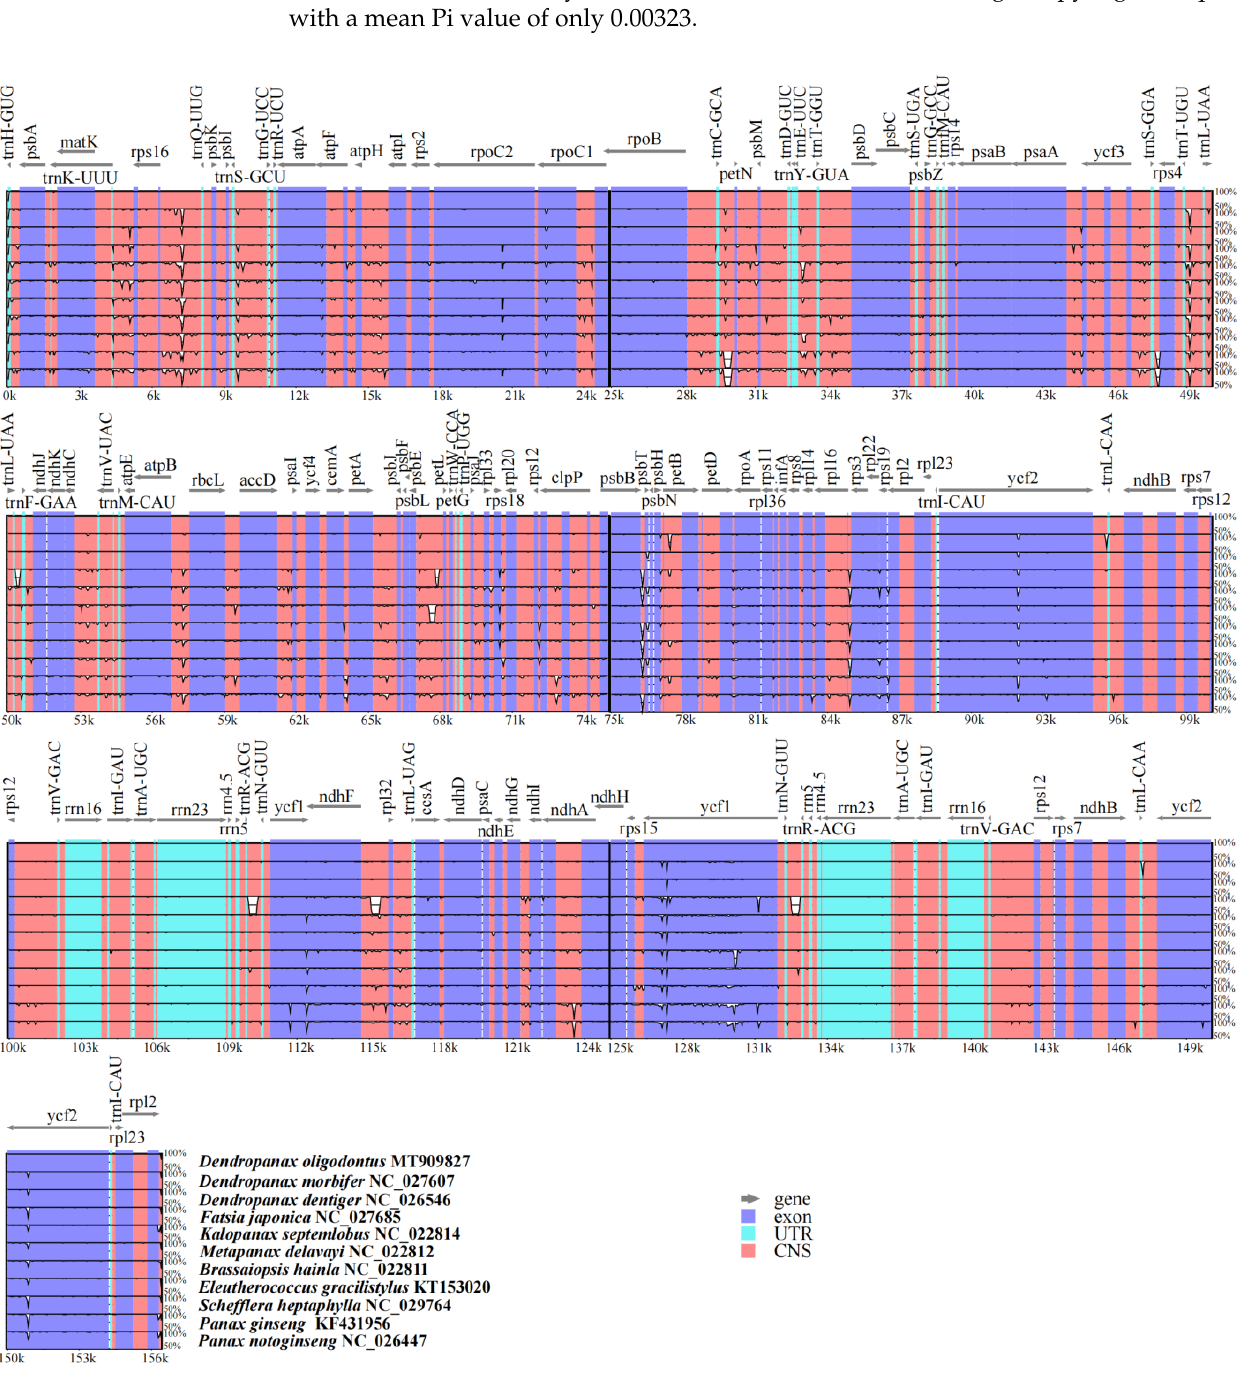
Figure 3. Visualisation alignment of the chloroplast genome sequence of 11 species. The identity percentages are shown on the y-axis and range from 50% to 100%, while the horizontal axis shows the position within the chloroplast genome. Each arrow indicates the annotated genes and the direction of their transcription in the reference genome. Genome regions, i.e., exons, untranslated regions (UTRs), conserved noncoding sequences (CNS), and mRNA, are colour-coded. The nucleotide diversity (Pi) of cpDNA in 11 Araliaceae species was analysed using DnaSP software, as shown in Figure 4. The Pi values ranged from 0 to 0.04882, with an overall genomic Pi mean value of 0.00639. Regions with high nucleotide diversity were distributed in the LSC and SSC, and the vast majority were present in the spacer regions of genes, such as trnK – rps16 , rps16 – trnQ , atpH – atpI , trnE – trnT , psbM – trnD , ycf3 – trnS , and rpl32 – trnL . The genes clpP and ycf1 had relatively higher Pi values (Figure 4). The mean Pi